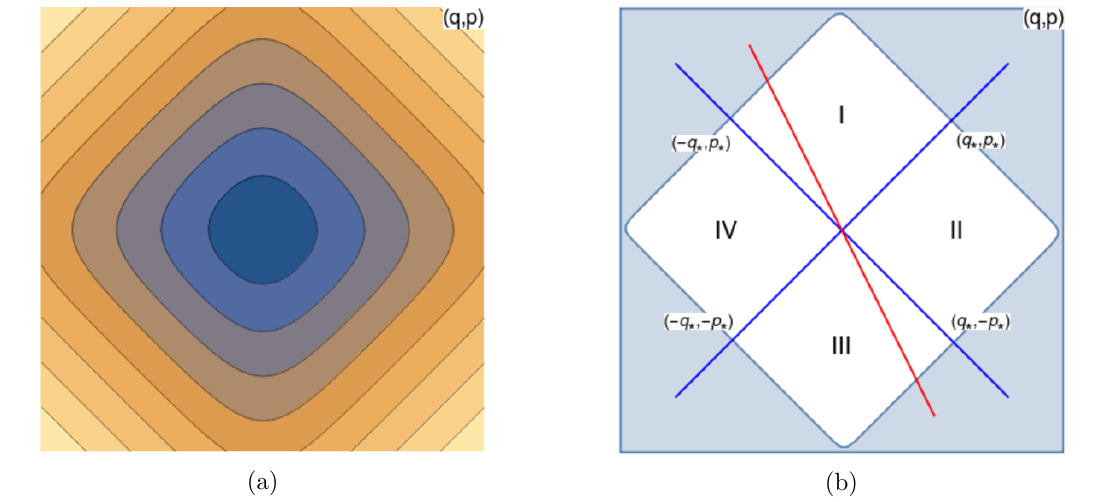
Figure 2. (a) shows the lines of constant H W in ( q; p ) space, de(cid:12)ning the Fermi surface. In (b) the Fermi region is divided into 4 areas. The red line has equation p = (cid:0) a where the exponent of the operator (4.15) is positive or negative, for a given 0 < b (cid:17) (cid:23) < 1 and a =